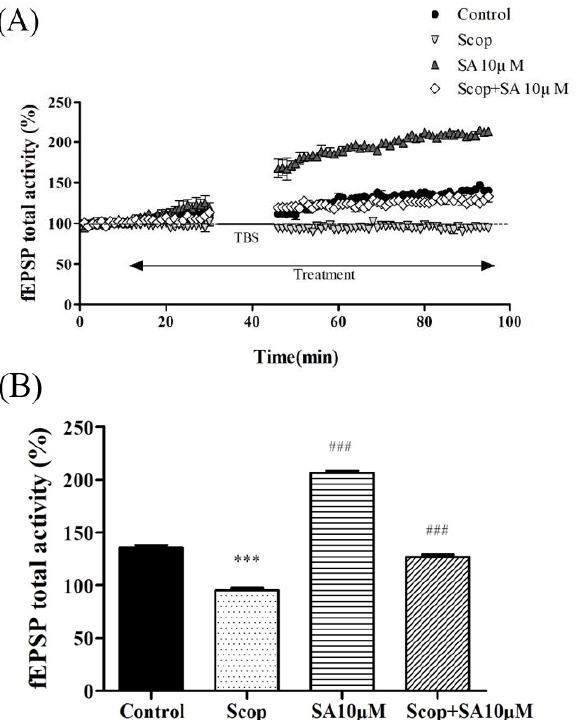
Figure 3. The effect of SA on long-term potentiation in SCOP-treated hippocampus. ( A ) fEPSP total activity (%) change induced by TBS while treatment of 10 µ M of SA and 300 µ M of SCOP in the organotypic cultured hippocampus. ( B ) Average of fEPSP total activity of 30 to 40 min after TBS during treatment of 10 µ M of SA + 300 µ M of SCOP in organotypic cultured hippocampus. n = 4. *** p < 0.001 vs. the control group. ### p < 0.001 vs. the SCOP group. Analyzed by one-way ANOVA with LSD test.